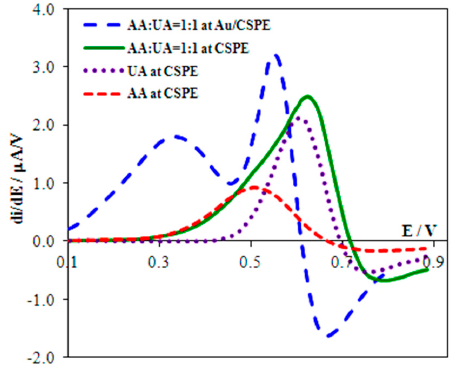
Figure 4. Derivative anodic voltammograms of 0.1 mM UA, 0.1 mM AA at CSPE and their mixture at CSPE and Au(5nm)/CSPE. Background: PBS (pH 5), ν = 50 mV/s.